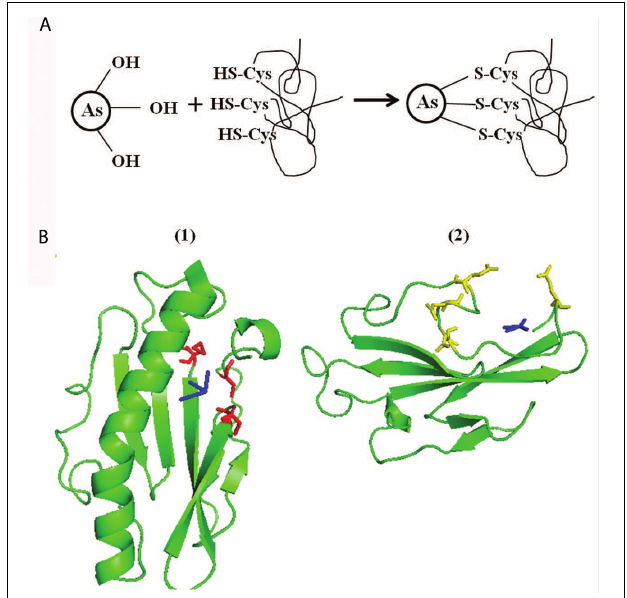
FIGURE 4 | Molecular docking of Synechocystis PilA and arsenic. (A) Schematic representation of As (III) binding to three closely spaced sulfur containing amino acids (i.e., cysteine or methionine). (B) As (III) (shown in blue color) shows potential binding site at three -S containing amino acids (two cysteines and one methionine, shown in red color). (1) As (V) (shown in blue color) shows potential binding at C-terminal pocket rich in acidic amino acid (aspartic acid and glutamic acid, shown in yellow color). (2) For As (III) and As (V) docking, only area of interest of PilA1 has been